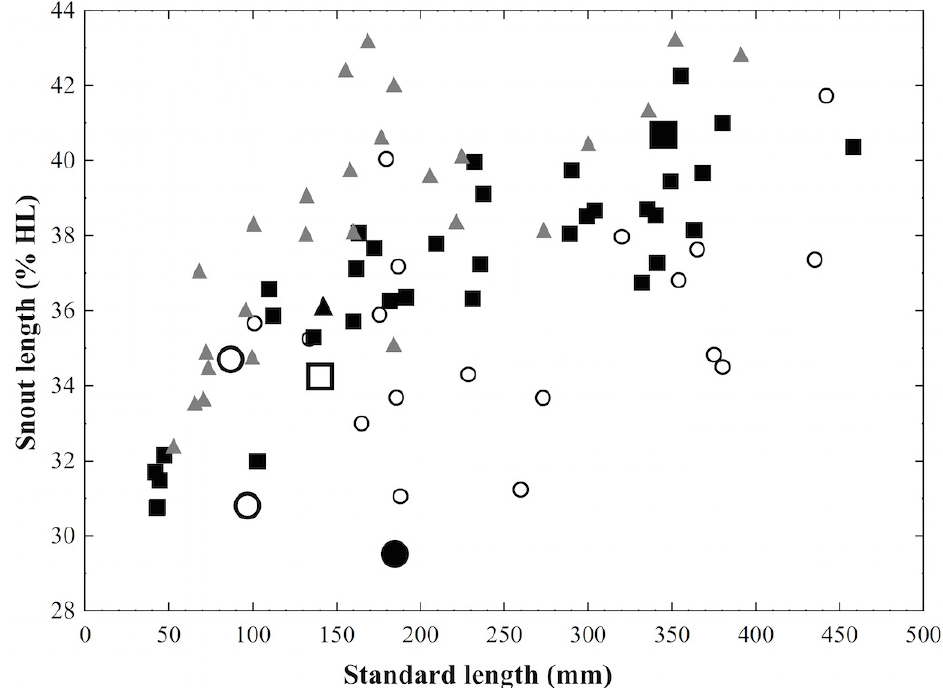
Fig. 9. Scatterplot of snout length (% HL) vs SL (mm) of the witvis, sawfin and Clanwilliam yellowfish to show the consistently longer snout of the witvis and sawfin. Specimens of Clanwilliam yellowfish with ‘rubberlips’ have longer snouts than normal and these exceptions intrude into the scatterfield of the witvis and sawfin. Barbus andrewi : o = holotype; B. capensis : ¢ = holotype, n = specimens; B. serra : p = holotype, r = specimens; Labeobarbus seeberi : ¡ = lectotype and paralectotype, ¡